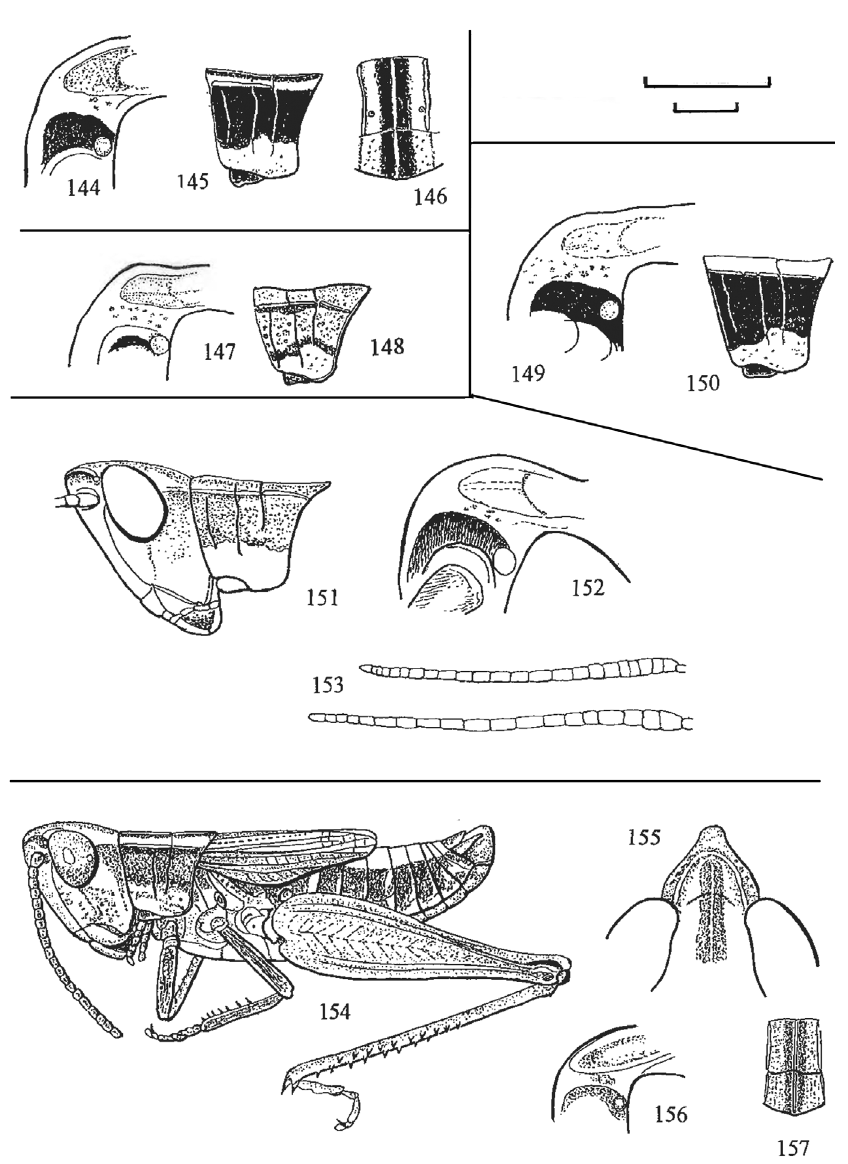
Figs 144–157. Tribe Gymnobothrini. Coryphosima spp. Figs 144–146. C. triangularis : 144. Oblique view of vertex; 145. Lateral aspect pronotum; 146. Pronotal disc. Figs 147, 148. C. amplificata : 147. Oblique view vertex; 148. Lateral aspect pronotum; Figs 149, 150. C. morotoensis : 149. Oblique view vertex; 150. Lateral aspect pronotum. (see also Fig. 163). Figs 151–153. C. stenoptera colorata male: 151. Lateral aspect head and pronotum; 152. Oblique view of vertex; 153. Comparison of antennae in subsp. stenoptera (upper) and colorata (below). Figs 154–157. C. elgonensis male: 154. Lateral aspect whole insect; 155. Dorsal aspect vertex; 156. Oblique view of vertex; 157. Pronotal disc. All scale lines represented by 1 mm: Upper scale line applies to Figs 144, 147, 149, 152, 155, 156; lower scale applies to Figs 145, 146, 148, 150, 151, 153, 154, 157. Discussion. —South Sudan series are darker, with a more deeply sulcate frontal ridge, and a smoother surface of fastigium of vertex than Ethiopian material. Subspecific status is, however, not war- ranted. Dirsh (1966) synonymized abyssinica with elgonensis , but this has been widely ignored by subsequent authors (Johnston 1968, Otte 1995, Cigliano et al. 2018) and it is here formally re- stored from synonymy.